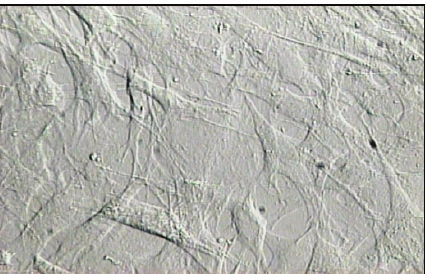
Figure 5: Mesenchymal Wharton’s jelly stem cell. Dissociated mesenchymal Wharton’s jelly stem cells were dispersed in 10% FBS-DMEM and counted under a microscope with the aid of a hemocytometer. The mesenchymal cells were then used directly for cultures or stored in liquid nitrogen for later use. 24 hours after injury marked HUMSCs (3 × 10 5 cells/ 𝜇 L) with BrdU in 9 𝜇 L of normal saline were sucked in to a Hamilton syringe and were injectedslowlyatarateof0.25 𝜇 L/minbymicroinjectorto3separate places and transplanted into the three sites of lesion area (epicenter, distal, and proximal) at a depth of